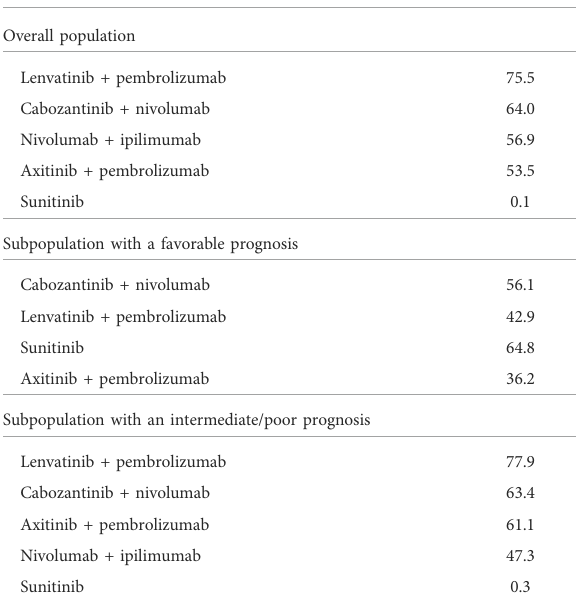
TABLE 4 The likelihood of being the preferred treatment option compared to the other treatment strategies probability of being the best treatment (SUCRA) in terms of overall survival.